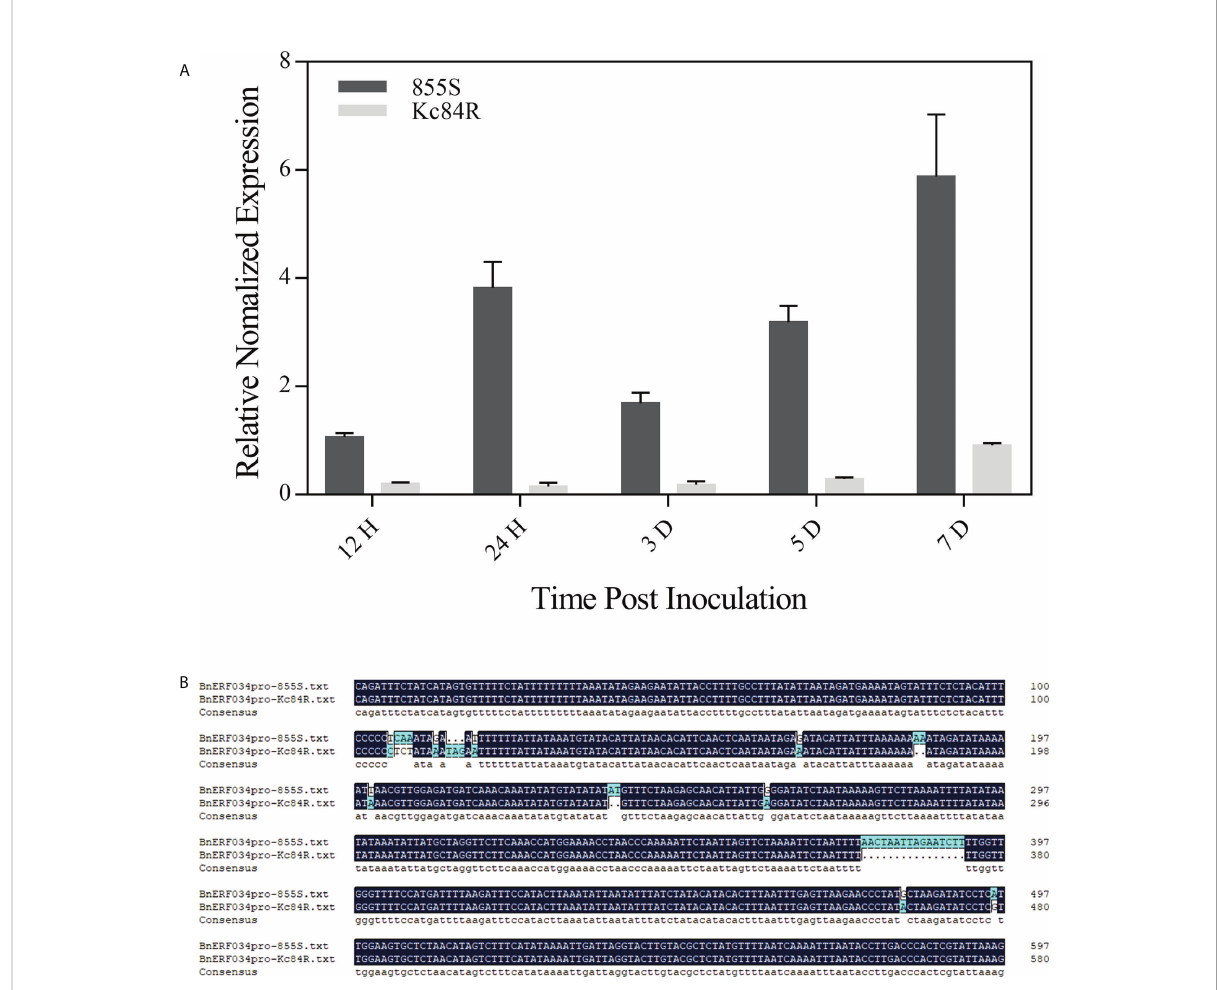
FIGURE 10 Expression patterns and predicted promoter regions of BnERF034 in Kc84R and 855S. (A) Expression patterns of BnERF034 in Kc84R and 855S in hydroponic culture infection with P. brassicae . (B) Sequence alignment of predicted promoter regions of BnERF034 in Kc84R and